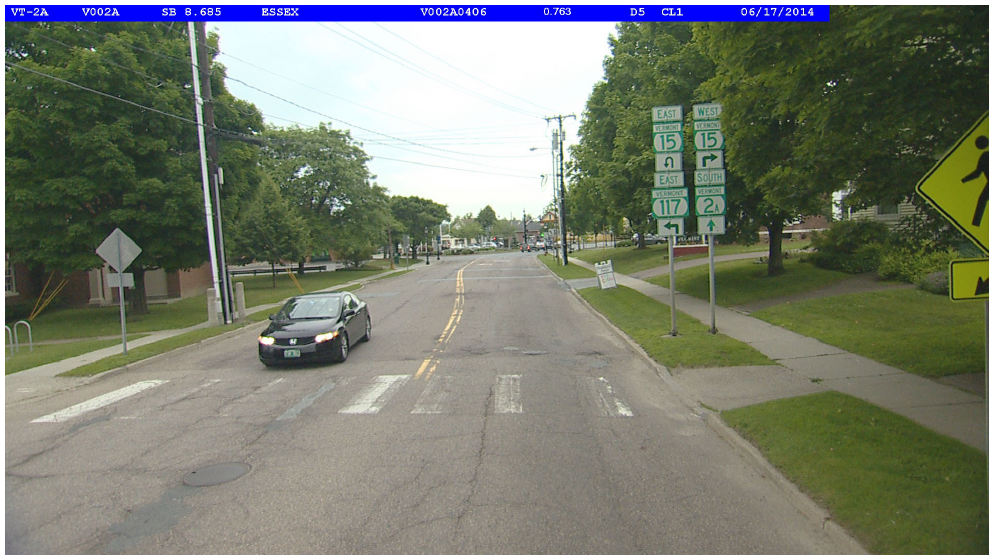
Figure 1. An example of a sign assembly containing multiple signs of similar appearance. All of the signs on the assembly have a green and white appearance, so it is difficult for a model to distinguish between them. There are two signs containing the word “East” which appear essentially identical. There are also two signs with the text “Vermont 15”. The arrow in the bottom left is a mirrored version of the arrow in the middle right. Since these signs contain so many similar characteristics, and in some cases are nearly identical, it is extremely challenging to create a geo-localization model that separately geo-localizes these